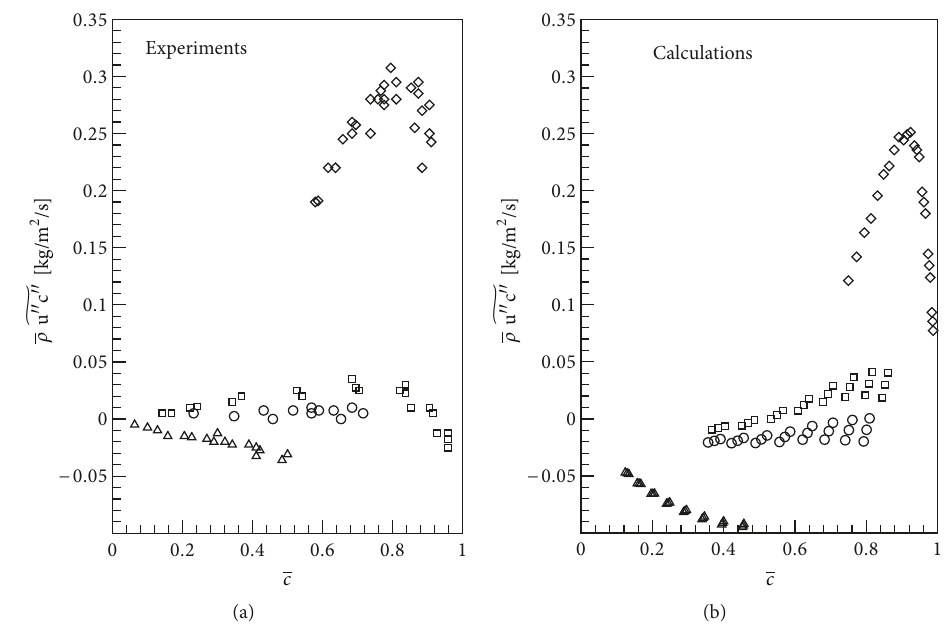
Figure 4: Comparison of experimental [14] (LHS) and theoretically estimated [15] (RHS) scalar flux in the fixed section of the turbulent Bunsen